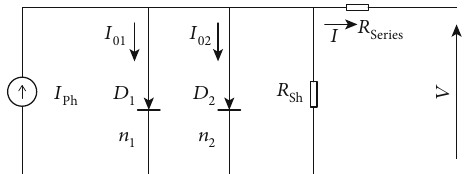
Figure 12: Schematic of the two-diode model used for the I-V curve fi